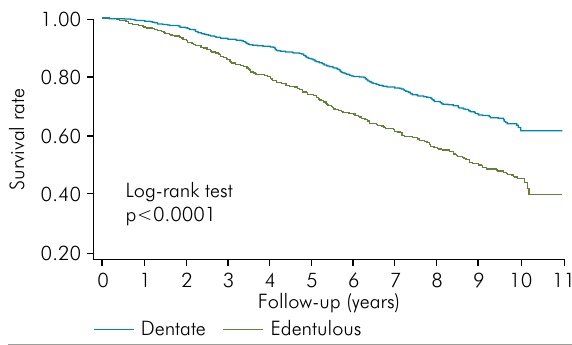
Figure. Kaplan–Meier survival curves according to edentulism among Brazilian older adults.